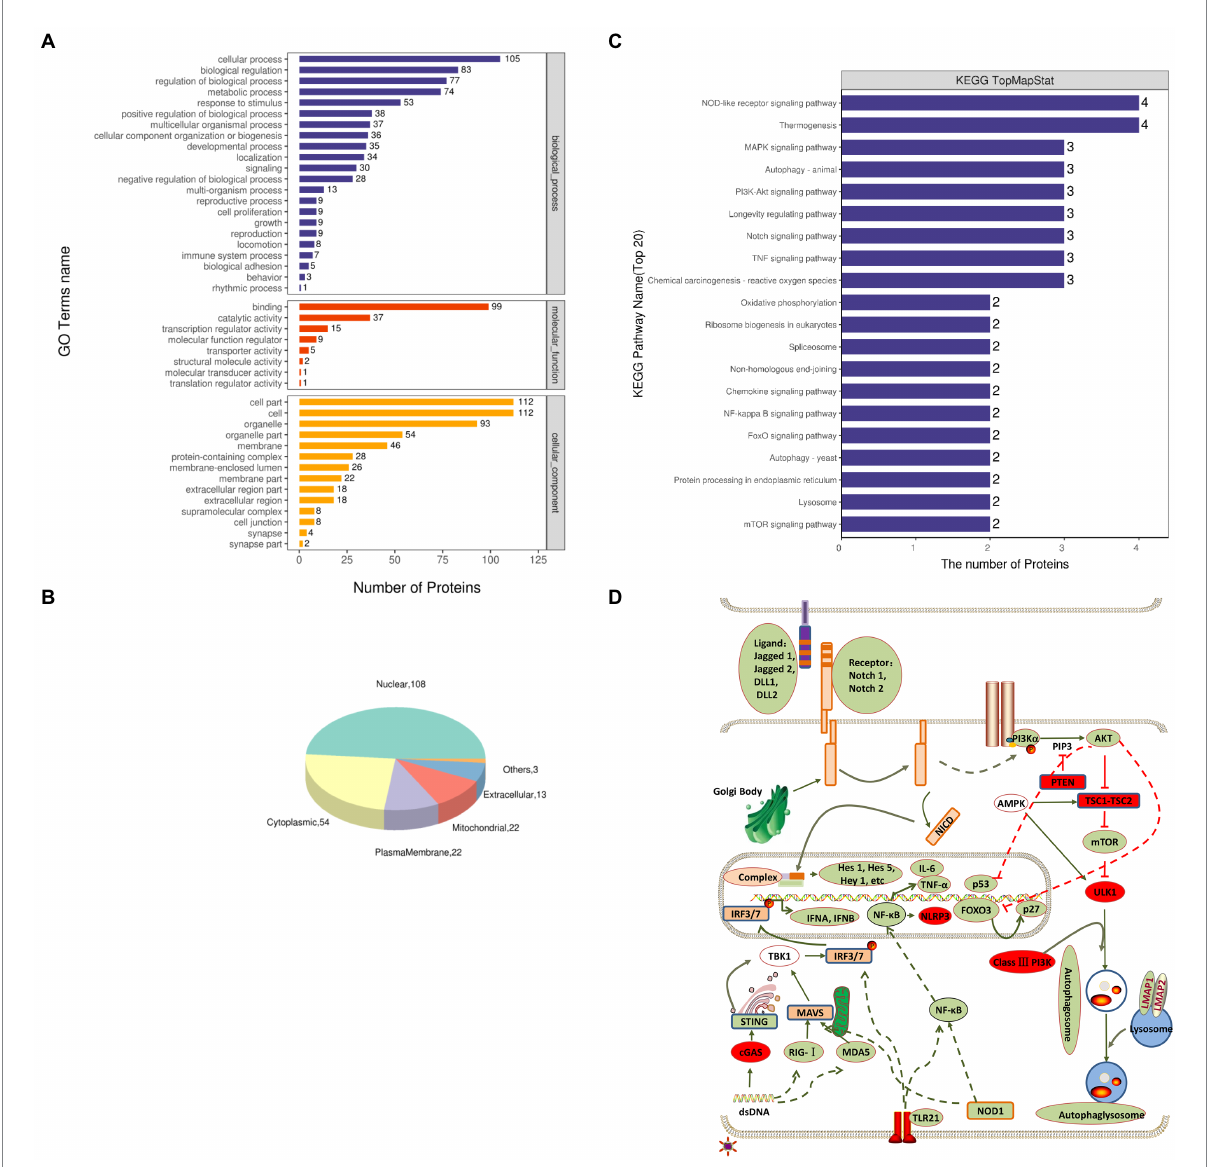
FIGURE 2 Gene Ontology (GO) and Kyoto Encyclopedia of Genes and Genomes (KEGG) enrichment analyses of DEPs. (A) Total GO categories in biological process, molecular function, and cellular component at 24 hpi. (B) Top 20 KEGG pathways for differentially expressed proteins. (C) Subcellular localization pie chart of differentially expressed proteins. (D) Schematic diagram of signal pathway changes in LMH cells infected with FAdV-4. The transcriptome levels of molecules that significantly increased at 24 hpi were filled with red, and those that significantly decreased were filled with